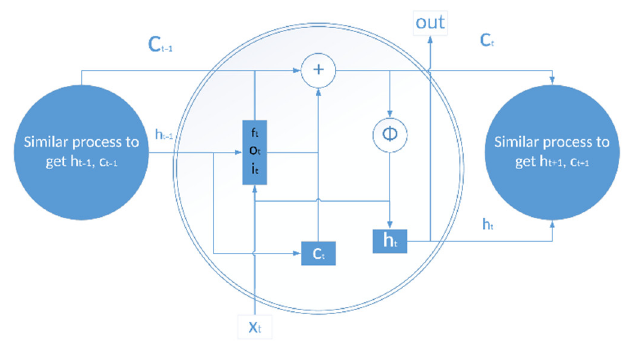
Figure 4. Memory block with the memory cell C t .